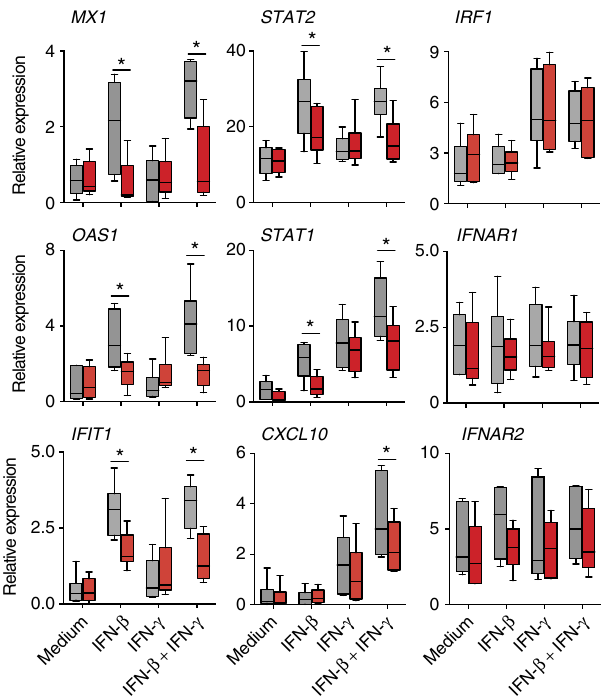
Fig. 3 TCC/Del genotype PBMCs have reduced response to type I but not type II IFN. PBMC with TCC/TCC (gray) or TCC/Del (red) genotype were stimulated with IFN- β or IFN- γ or both (at 100 U/ml) for 6 h and gene expression analyzed using qRT-PCR. The data shown are the median and range ( n = 6/genotype) of mRNA expression relative to GAPDH . Box plots represent the median (solid line within the box) and 25th and 75th percentile. The whiskers indicate minimal and maximal